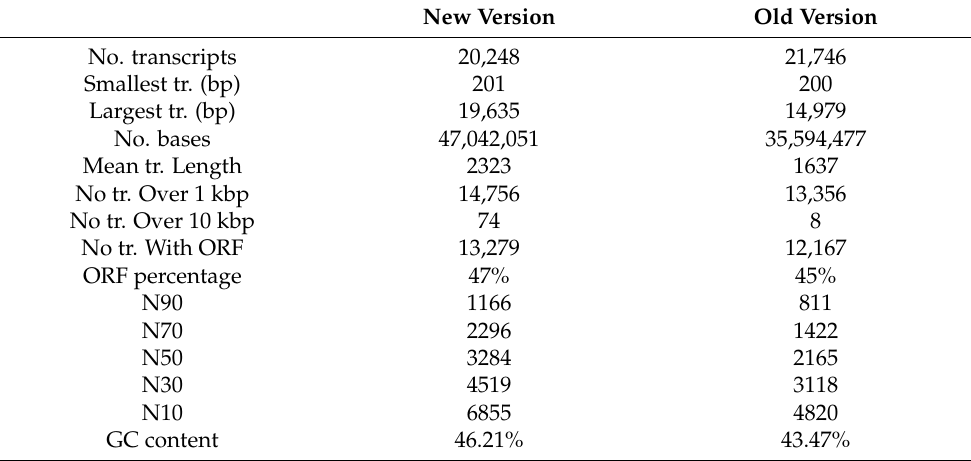
Table 2. Transcriptome assembly statistics. Data generated by Transrate [32].